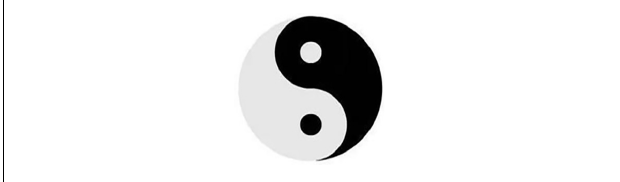
FIGURE 3 | The Interaction and Interchangeability of Dialectical yin + yang